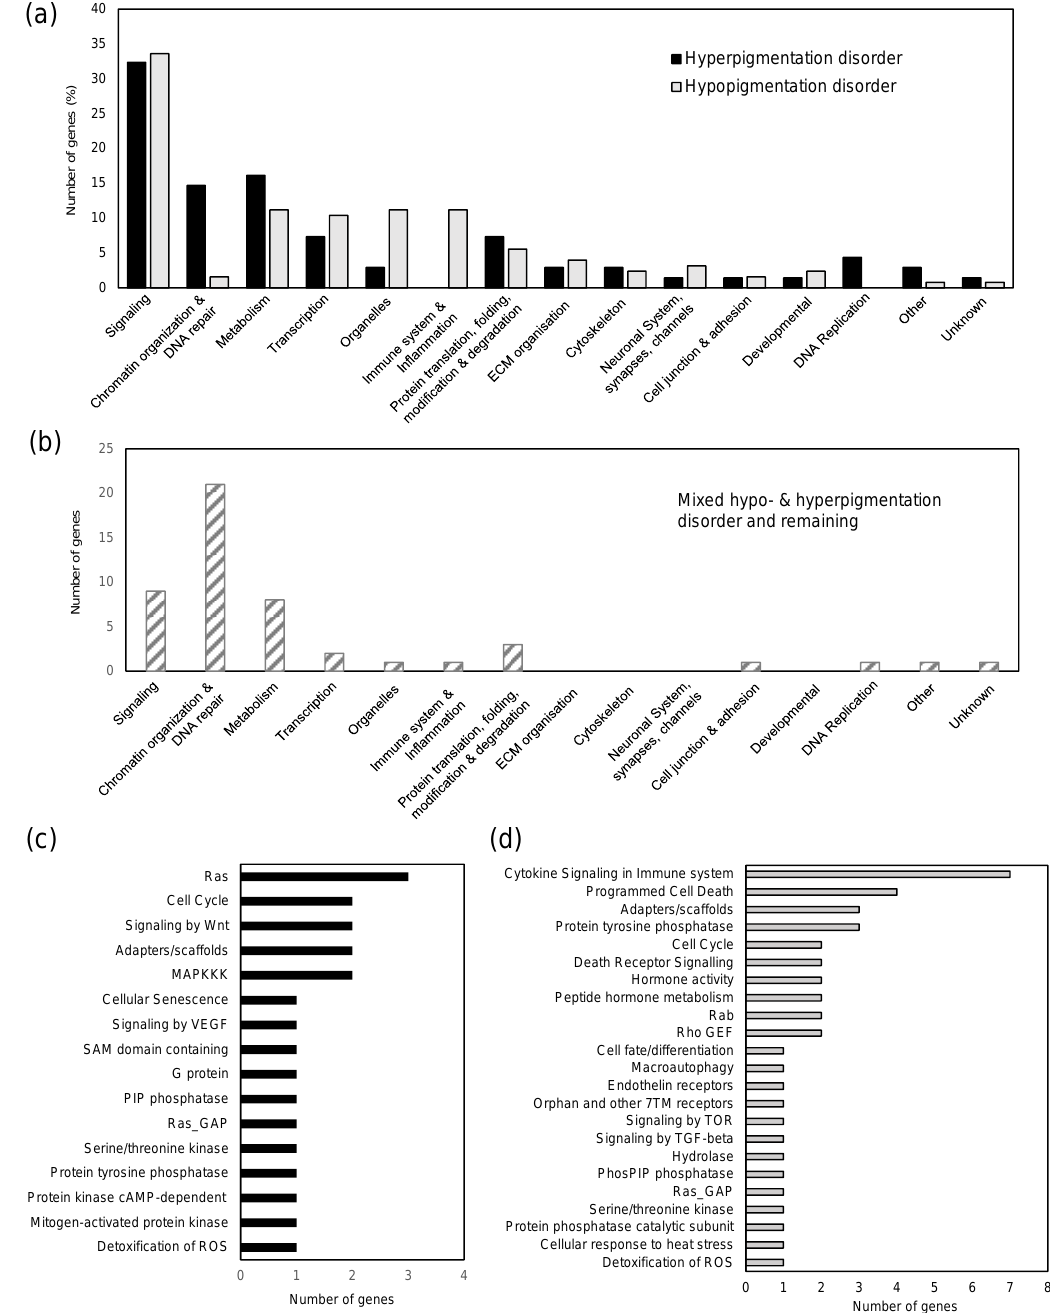
Figure 2. Functional analysis of pigmentation using the SysGO database (level 3). ( a ) Functional analysis comparing genes that are exclusively linked to hyperpigmentation diseases (total of 68 genes) to those that are exclusively linked to hypopigmentation disease (total of 125 genes). The number of genes is shown as percentage of total genes in each class (hyper- or hypopigmentation). ( b ) Functional analysis of genes linked to mixed hypo- and hyperpigmentation disorders and remaining genes (pigmentation phenotype genes and all genes that link to both, hyper- and hypopigmentation disorders) (total of 49 genes). ( c ) Further subclassification of hyperpigmentation genes in “signaling” into level 1 classes (total of 22 genes). Abbreviations: MAPKKK, Mitogen-activated protein kinase kinase kinase; SAM, Sterile alpha motif; PIP, Phosphatidylinositol-phosphate ( d ) Further subclassification of hypopigmentation genes in “signaling” into level 1 classes (total of 42 genes).